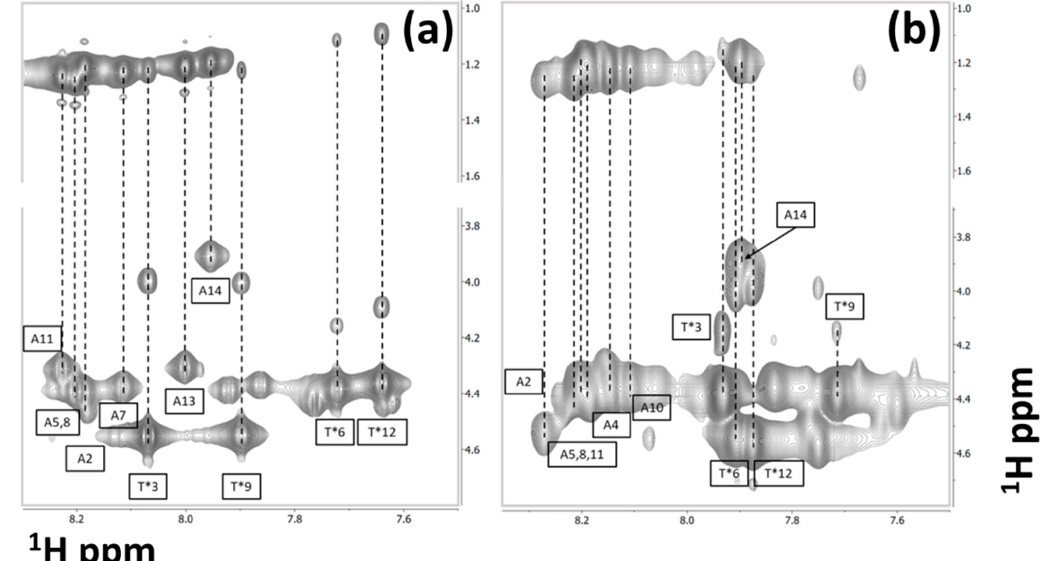
Figure 1. Sequence-specific chemical shift assignments of antifreeze glycoprotein fraction 8 (AFGP8). The 2D TOCSY NMR spectra of AFGP8-BS (AFGP8 from Boreogadus saida ) ( a ) and AFGP8-TB (AFGP8 from Trematomus borchgrevinki ) ( b ), showing the amide to alpha and methyl proton regions. The TOCSY patterns associated with all the amino acid residues of the primary sequence, except for the alanine residue at position 1 and proline residues at positions 4 and 10 in AFGP8-BS and positions 7 and 13 in AFGP8-TB. Table 1. Chemical shifts of AFGP8.